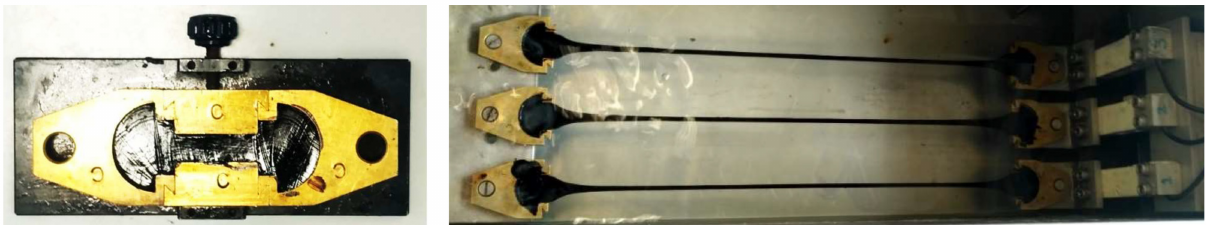
Figure 2. Force ductility test of PMBs: molds and specimens